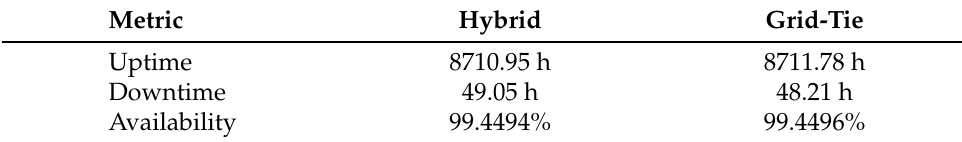
Table 4. Availability metrics results to whole